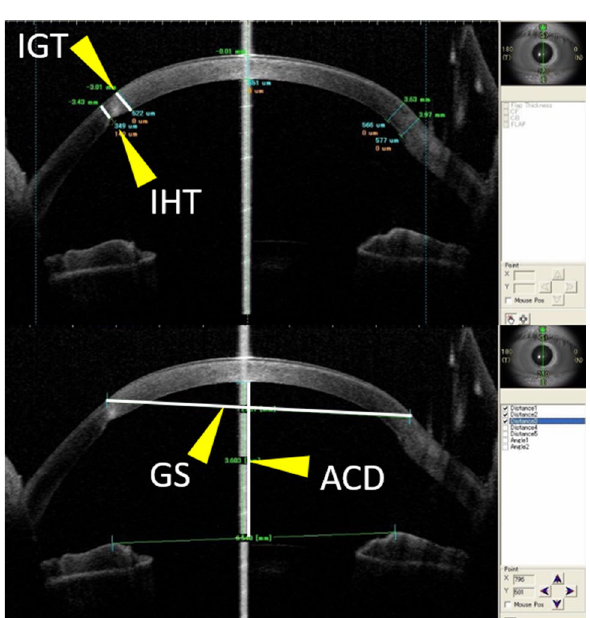
Figure 4. Scheme of each parameter measured by anterior segment optical coherence tomography. Vertical images were used for measurements. The thicknesses of the thinnest parts of the inferior graft (IGT) and host (IHT) cornea, graft size (GS), and anterior chamber depth (ACD) were